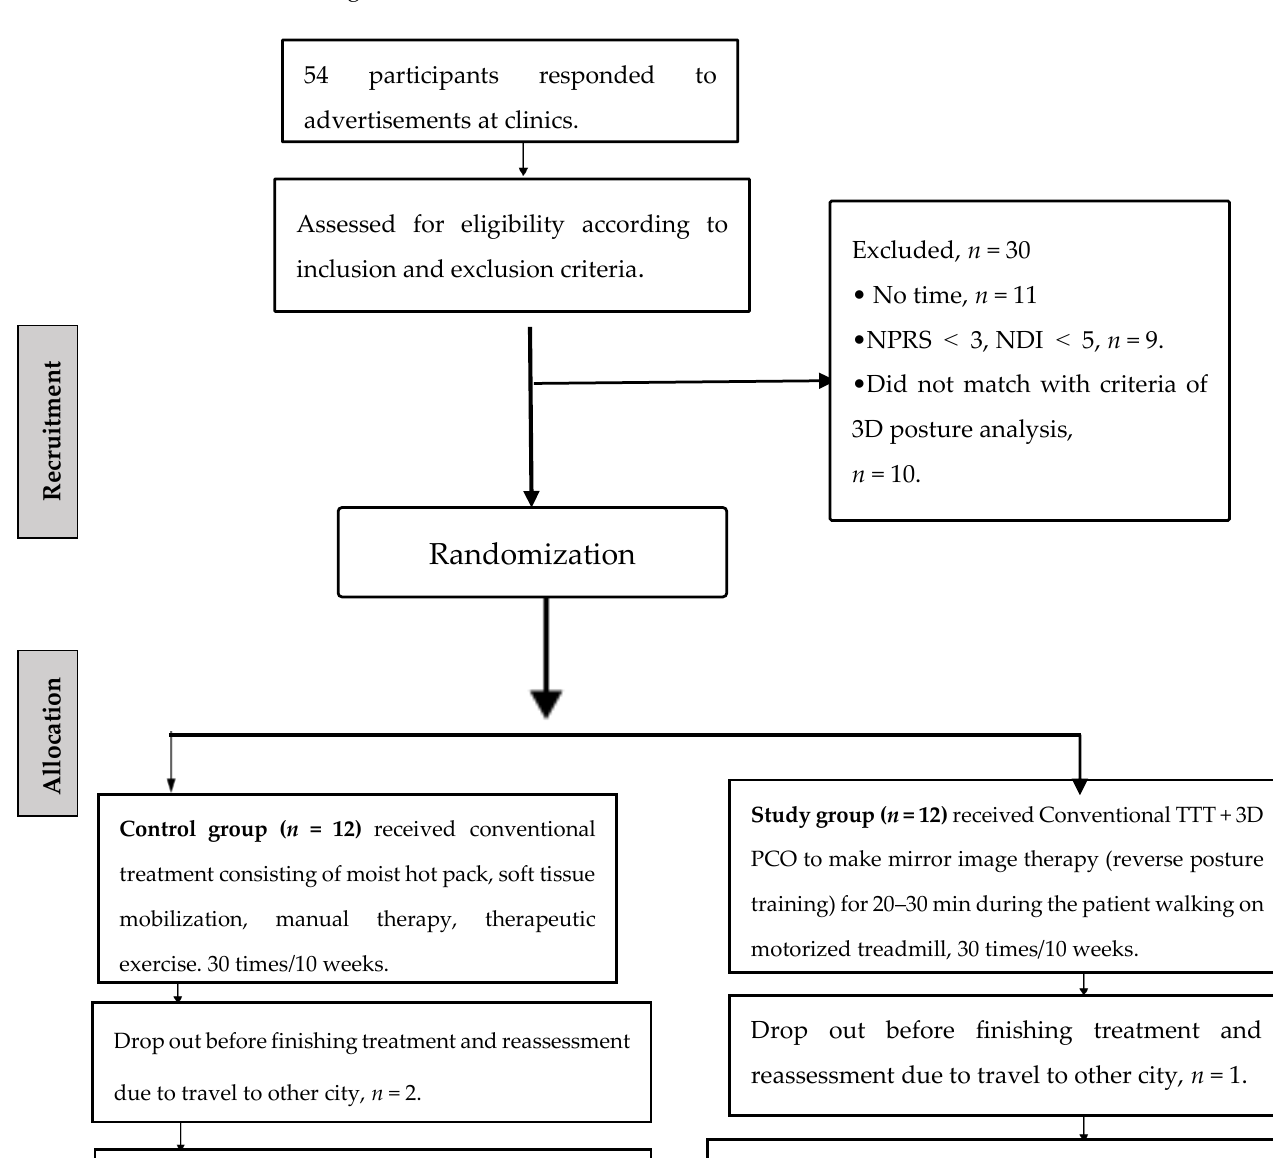
Drop out before finishing treatment and reassessment due to travel to other city, n = 1.